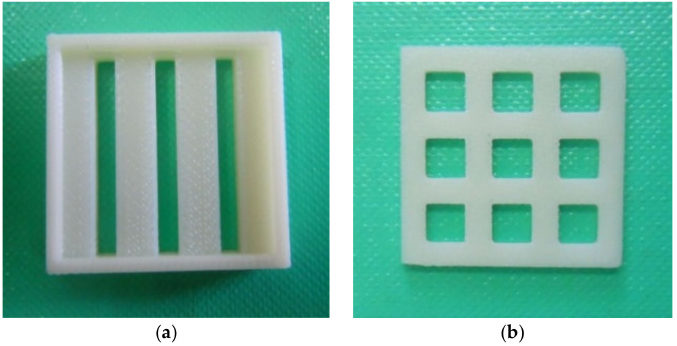
Figure 1. The 3D-printed